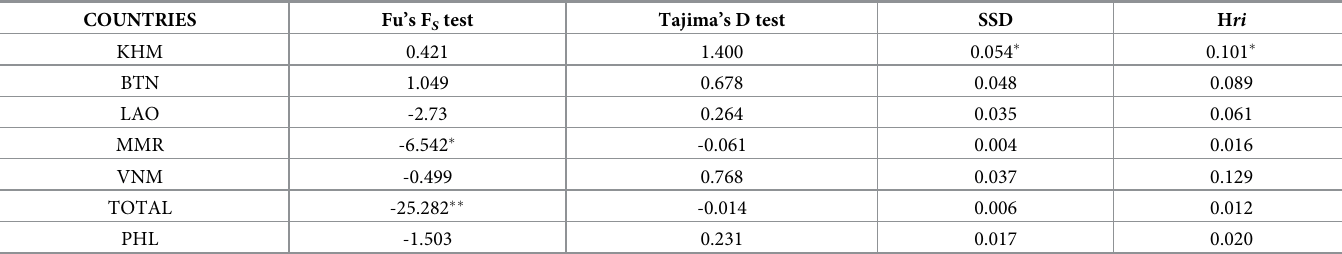
Table 4. Values of neutrality test (Fu’s F and Tajima’s D ), sum of square deviation (SSD) and Harpending’s raggedness index (H ri ) for Philippine domestic pigs S and MSEA pig mtDNA D-loop region. COUNTRIES